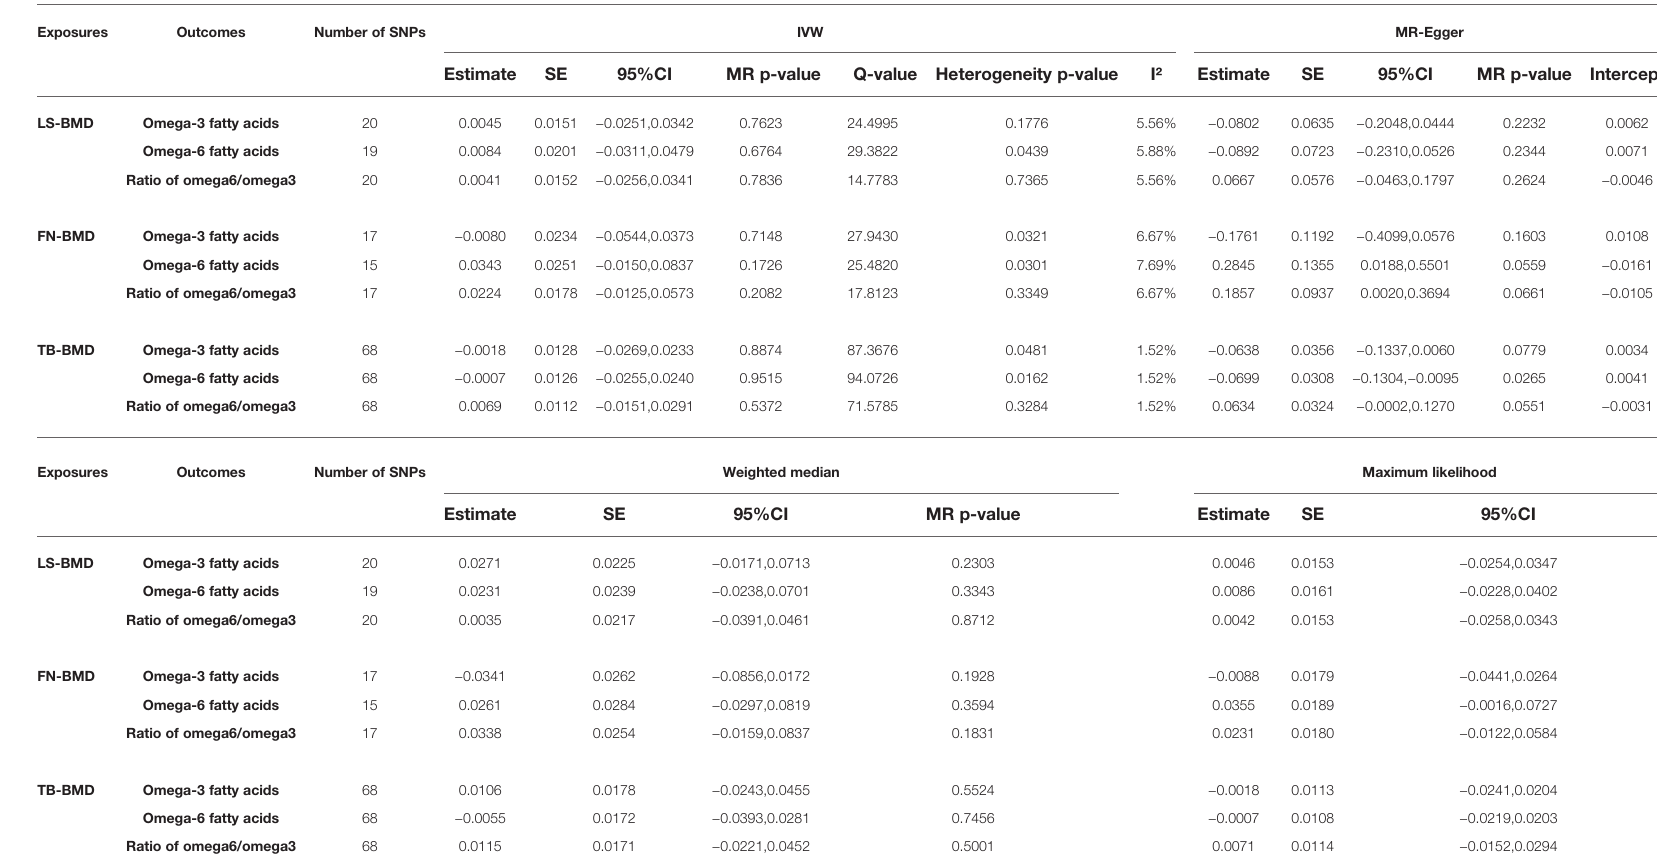
TABLE 4 | MR estimates of the causal effects of PUFAs on BMD using various analysis methods.